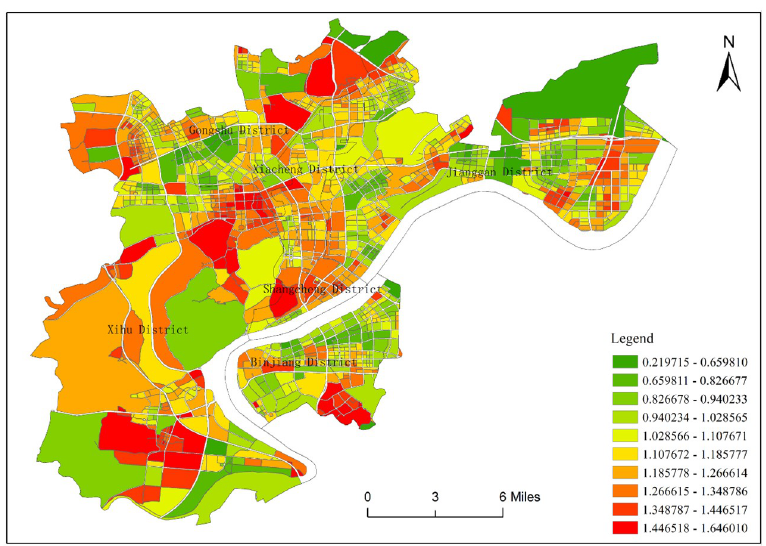
Fig 7. Distribution map of the mixed degree of functional areas in the central urban area of